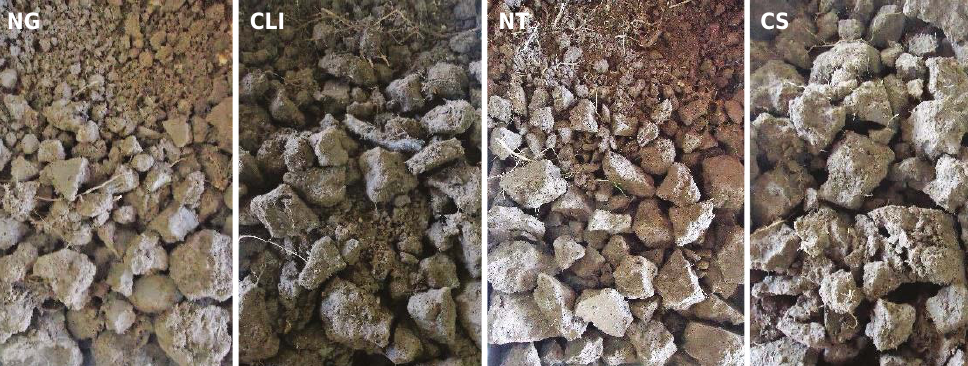
Figure 1. Pictures of the Visual Evaluation of Soil Structure (VESS) of an Albaqualf under different management systems in the 0.00-0.20m layer. NG: native grassland; CLI: crop-livestock integration; NT: no-tillage; CT: conventional tillage system.